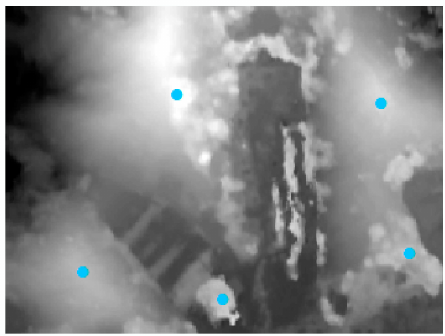
Figure 17. The distribution map of the third dataset extracted using the reference method.